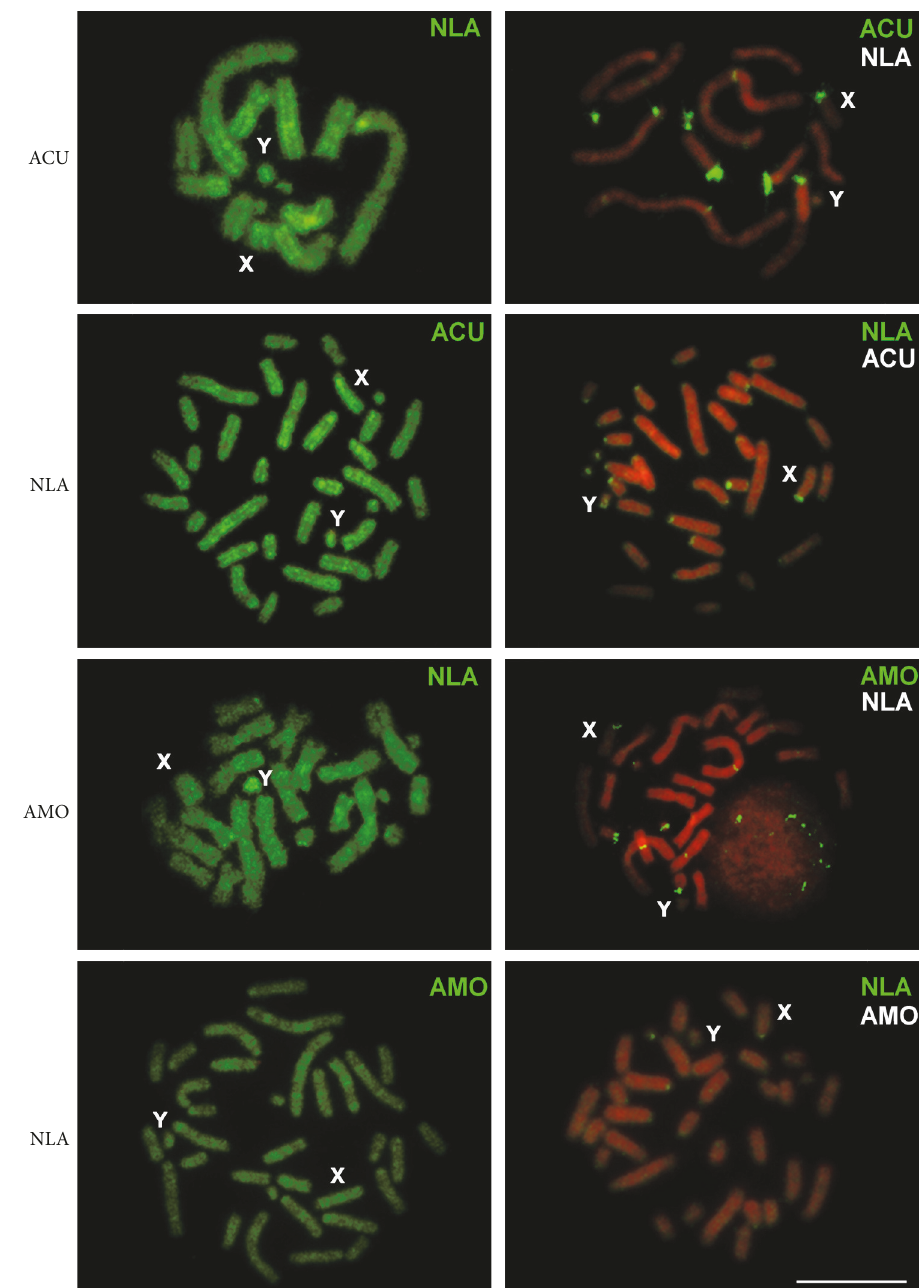
Figure 4: Interspeci fi c GISH among Akodon cursor (ACU), A. montensis (AMO), and Necromys lasiurus (NLA). The initials on the left correspond to the species cells. The labeled DNA used is identi fi ed in green, and the suppressor DNA is represented in white. All the cells were counterstained with propidium iodide. Bar=10 μ